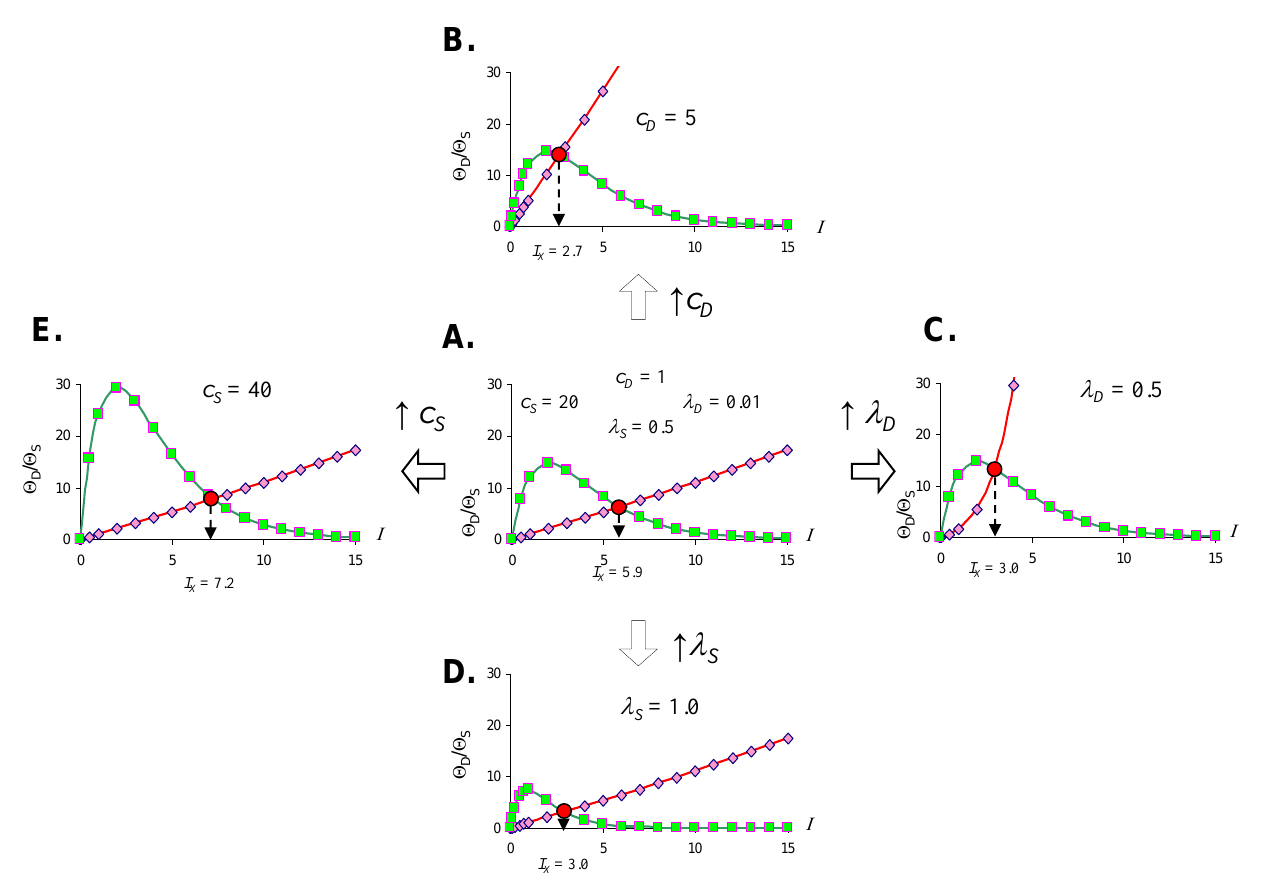
Figure 3. Threshold curves plot Θ system; ( B – E ) increase c Parameter values listed on